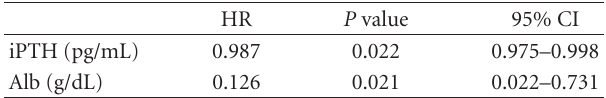
Table 4: Multivariate analyses of characteristics associated with APD in DM patients ( n = 27).